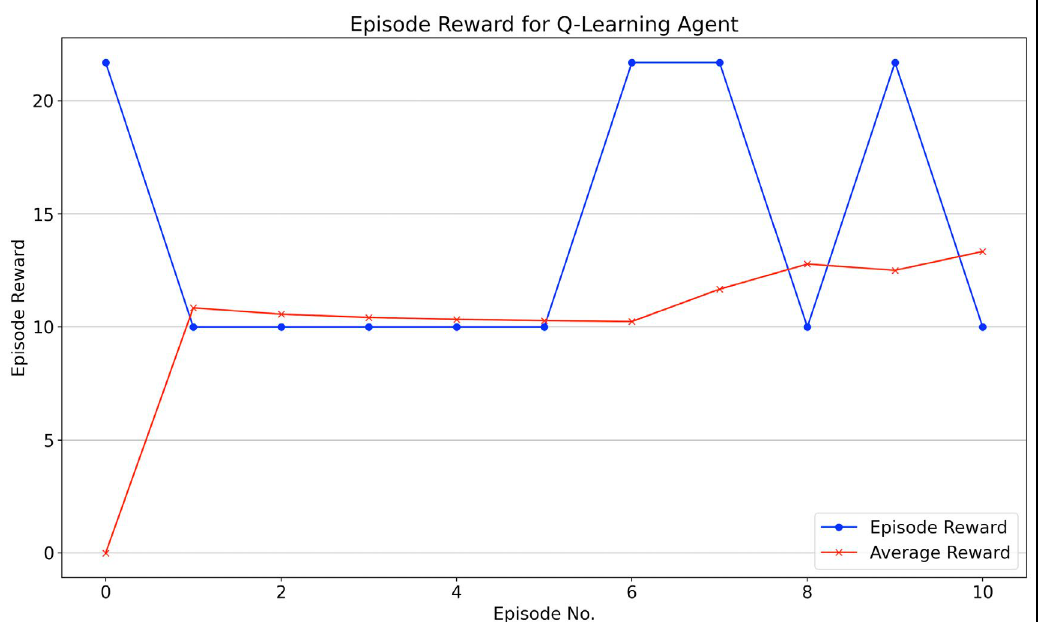
Figure 4. Results of Q-learning